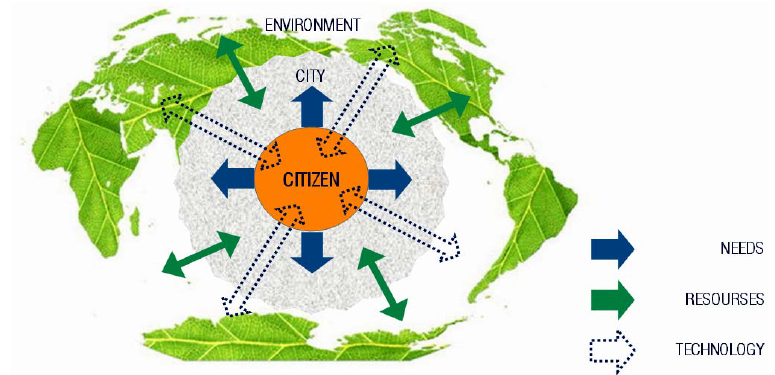
Figure 5. 360° relational